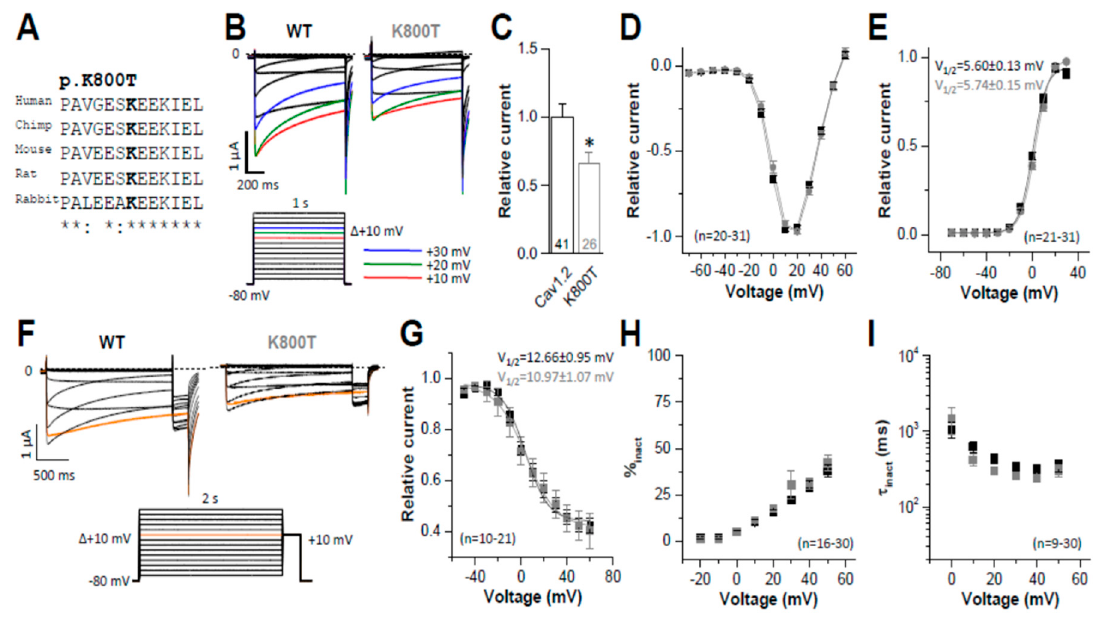
Figure 2. Own experimental analyses in the presented patient illustrated an isolated reduction in the current amplitude of L-type calcium channels without a change in kinetic properties. Two-electrode voltage-clamp measurements were performed in Xenopus oocytes, as previously described [2]. Ba 2 + was used as a charge carrier, and for all experiments, Cav1.2 was co-expressed with the α 2 δ and β 2b subunits [2]. In detail, the figure shows the following: ( A ) High evolutionary conservation of the K800 residue between di ff erent orthologues. ( B ) Representative current traces of wild-type (WT) Cav1.2 and mutant Cav1.2 K800T recorded with the indicated voltage protocol, in order to analyze the current amplitudes and the voltage-dependence of activation properties. ( C ) Reduced peak current amplitudes, analyzed at + 20 mV. ( D ) Normalized bell-shaped current voltage-relationship and ( E ) conductance-voltage (GV) relationship. The voltage of half-maximal activation (V1 / 2 act.) is indicated in the upper corner. ( F ) Representative current traces of wild-type Cav1.2 and Cav1.2 K800T recorded with the indicated voltage protocol, in order to analyze the inactivation properties. ( G ) Analyses of the voltage of half-maximal inactivation (V1 / 2 inact.). The V1 / 2 inact. values are provided in the upper corner. ( H ) Percentage of voltage-dependent inactivation of wild-type and Cav1.2 K800T analyzed at di ff erent voltage potentials. ( I ) Analyses of the time constant of voltage-dependent inactivation ( τ inact.) of wild-type and Cav1.2 K800T analyzed at di ff erent voltage potentials. Numbers of experiments are indicted in the panels. Data are presented as mean ± s.e.m. * indicates p < 0.05. With respect to these functional data, the p.Lys800Thr variant was classified as likely pathogenic